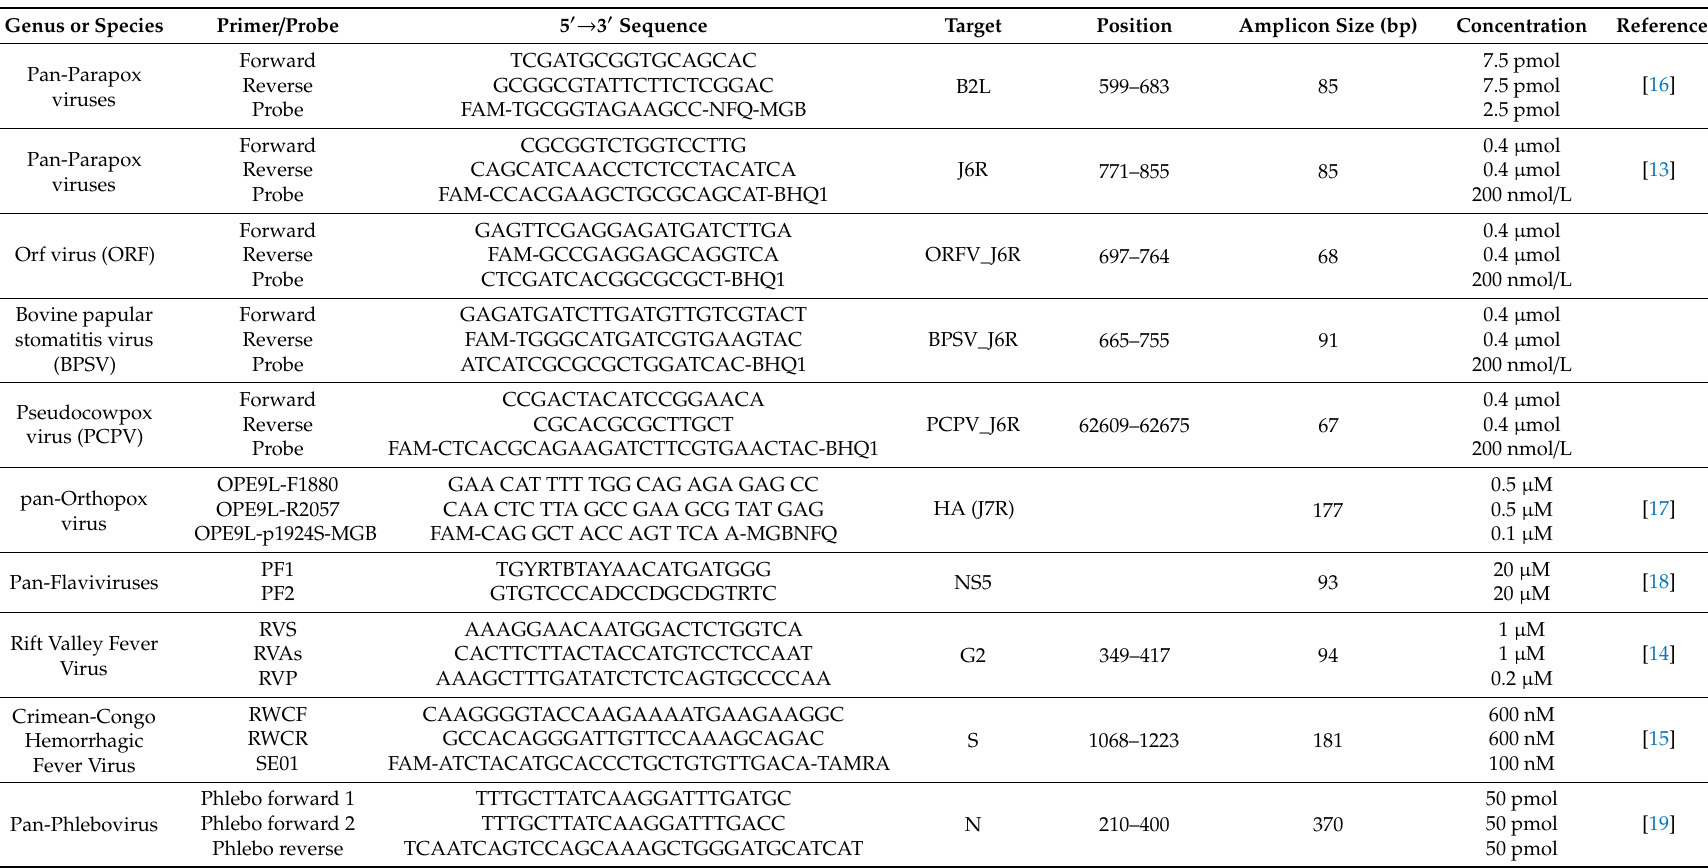
Table 1. Primers and probes used for genus- and species-specific real-time PCR